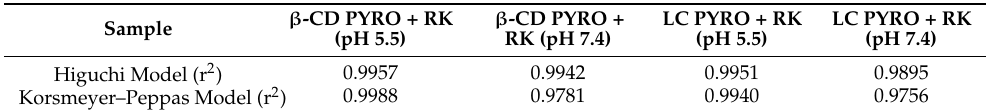
Table 5. Mathematical models fitting of release